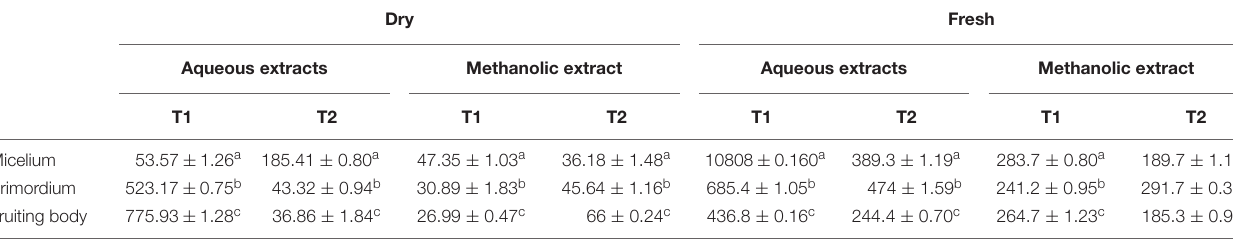
TABLE 5 | DPPH radical scavenging activity of P. ostreatus.